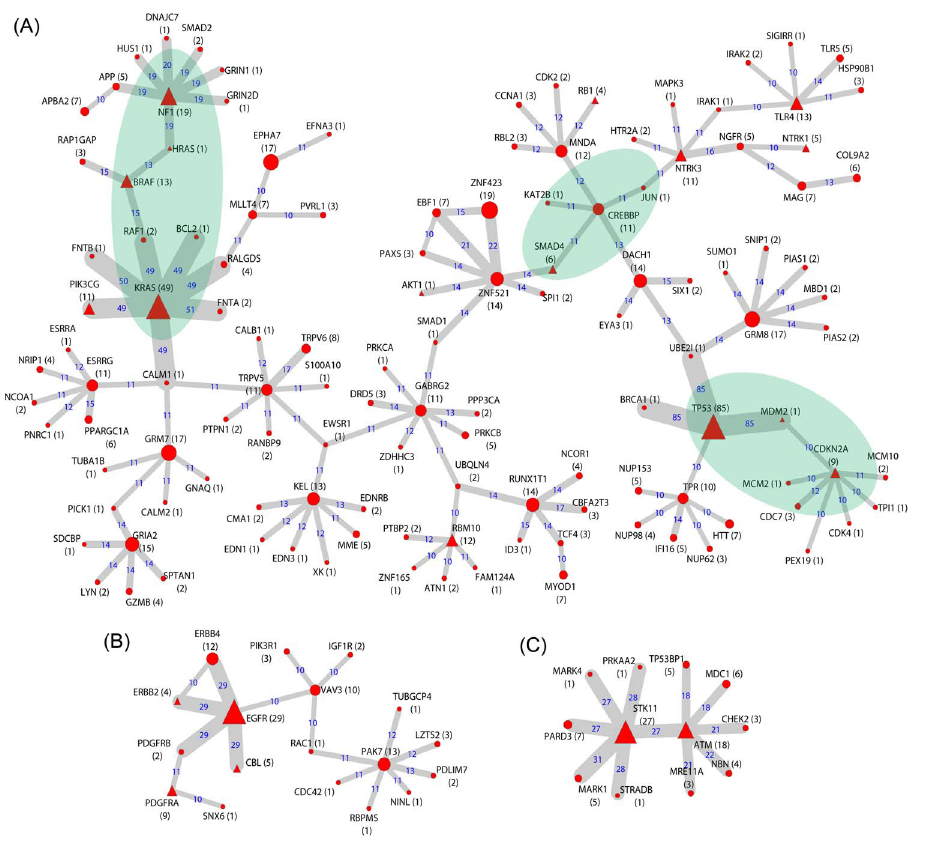
Figure 4. Selected subgraphs in the lung adenocarcinoma consensus mutation network. Node size is proportional to the number of samples harboring mutations in the corresponding gene (MutGene), as indicated in the parenthesis after the node name. The triangular nodes denote the proteins encoded by known LUAD genes (see Materials and Methods). Edge width is proportional to the number of samples in which the interaction is detected, which is also indicated by the number on each edge. Figures in (A), (B), and (C) show three selected subgraphs in LUAD.